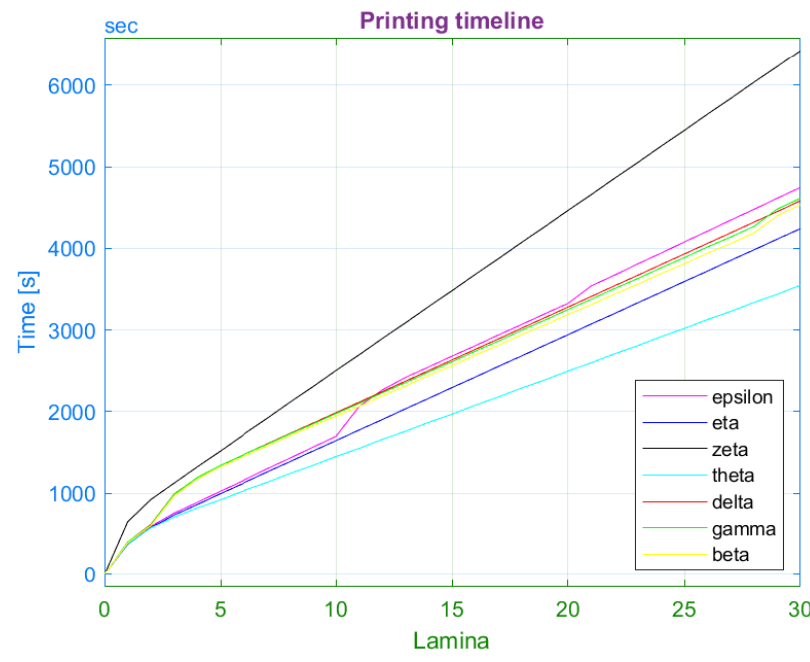
Figure 25 . Printing timeline of each laminate series. Figure 25. Printing timeline of each laminate series. Table 9 . Influence of the selected printing parameters on the reduction of printing time and ulti- mate strength.